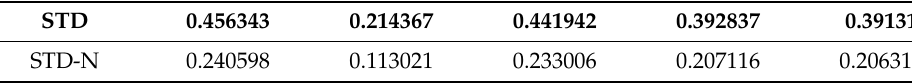
Table A2. Standard deviation of criteria.